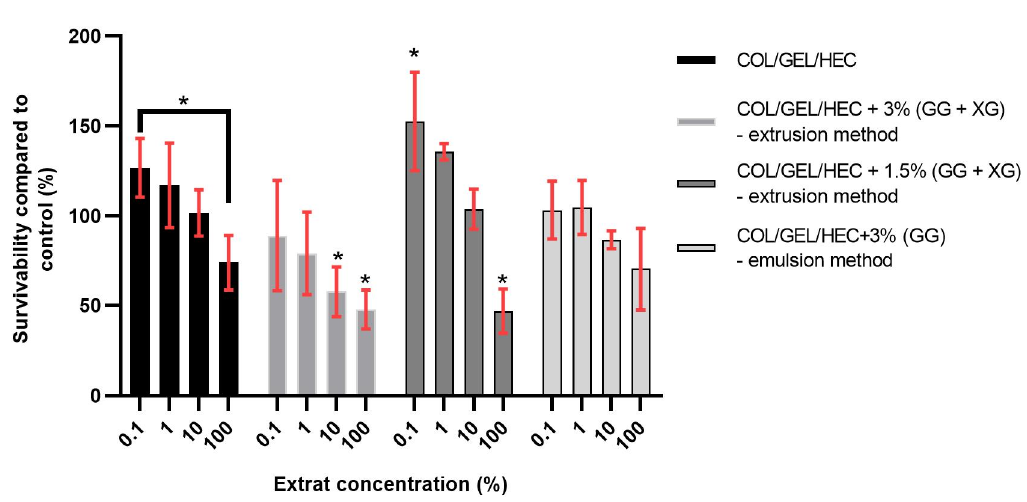
Figure 7. The survivability compared to the control of 3t3 cells after 24 h of exposition to COL / GEL / HEC matrices extracts acquired from MTT assay. ANOVA-one way with Dunnett’s post-hoc analysis (Cl = 95%) was performed to statistically compare the results. Significant differences compared to the control were marked on the graphs with (*), comparisons to results other than the control were indicated via clamps.